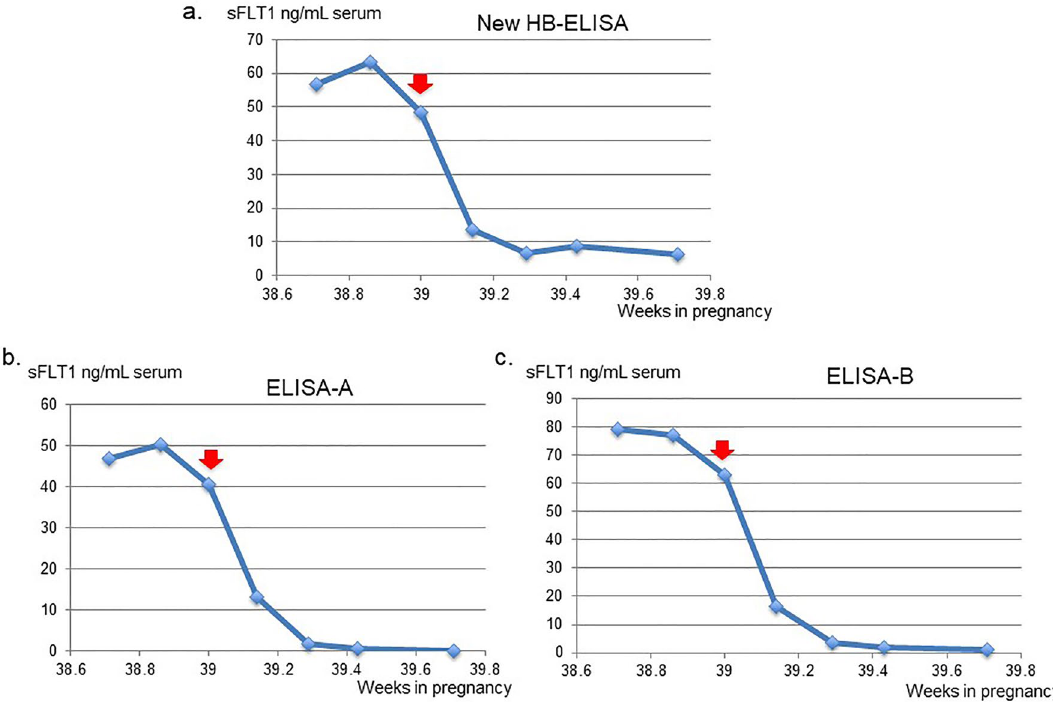
Figure 4. A rapid decrease in the serum sFLT1 levels after delivery in severe PE case. We compared the sFLT1 values detected with new HB-ELISA ( a ) and those with commercially available two sFLT1 ELISA kits, ELISA-A ( b ) and ELISA-B ( c ), using the same serum samples obtained from a single PE patient at 7 different time points. ( a ). A case of severe PE (PE-A) showed high sFLT1 levels, at approximately 60 ng/mL in the serum before delivery. Three days after delivery, the sFLT1 levels dramatically decreased to lower than 10. Red arrow: delivery date. “weeks”: weeks of pregnancy. ( b , c ) The sFLT1 values detected with two commercially available ELISA kits showed very similar sFLT1 patterns as that with new HB-ELISA method shown in ( a